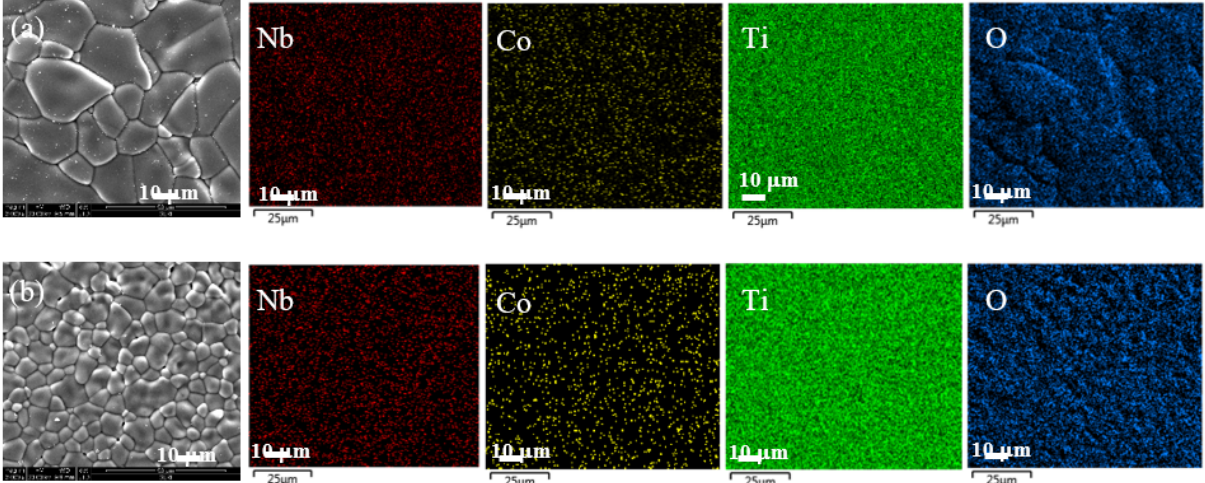
Figure 2. Field emission scanning electron microscope (FE-SEM) images and mapping images of all elements of ( a ) 0.5% CoNTO and ( b ) 1% CoNTO ceramics.